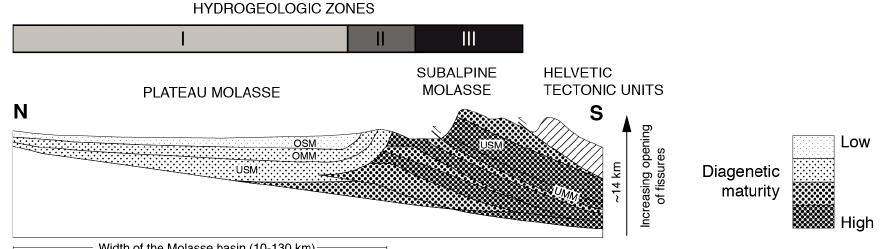
Figure 2. Conceptual N–S profile through the Molasse basin for illustrating the present architecture of the four Molasse units as a result from tectonic thrusting from south and surface erosion. The hydrogeological zones from north to south are also shown, based on the degree of diagenetic maturity, compaction, and tectonic deformation: (I) zone with average primary porosity and weak fissure porosity in the Plateau Molasse; (II) zone with important fissure porosity and weak primary porosity in the Folded Molasse; (III) zone with important fissure porosity but unimportant primary porosity in the Subalpine Molasse. The groundwater flows that are considered in this study only affect the uppermost couple of hundred meters. The full depth of the profile is shown here for illustration of the Molasse architecture and as a complement to the surface maps (Figures 1 and 3). Figure adapted from Keller